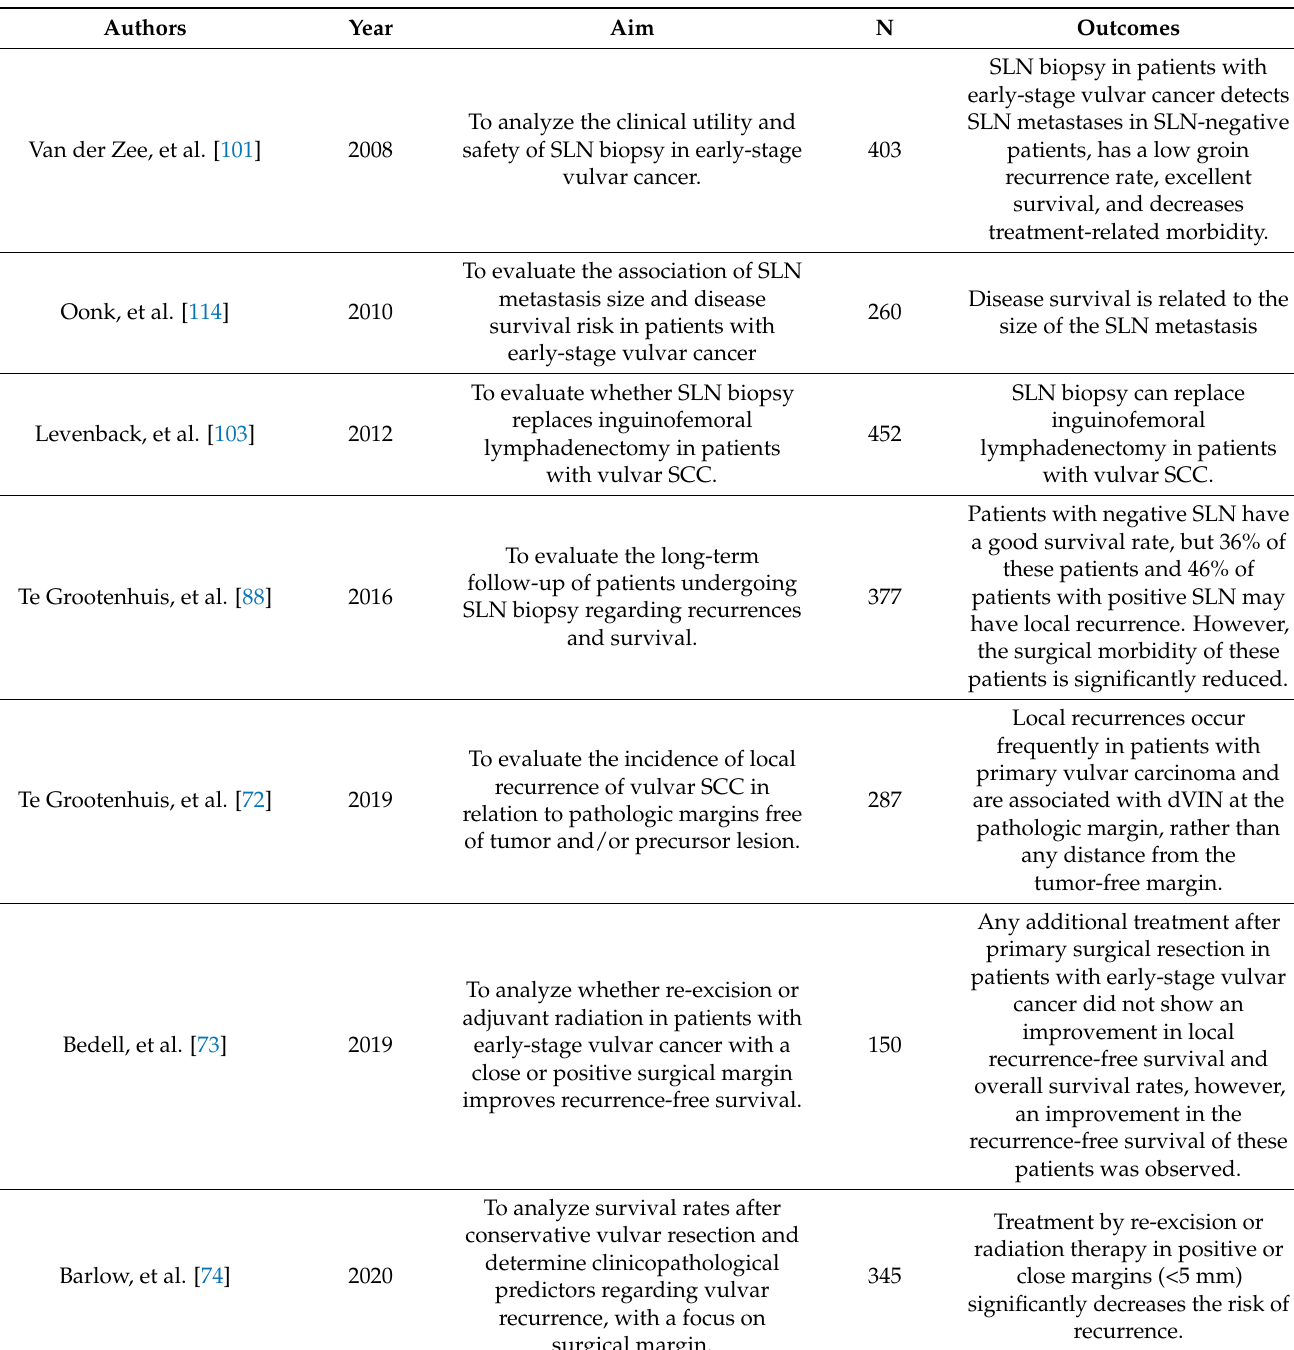
Characteristics of the main vulvar cancer studies on sentinel lymph nodes and surgical